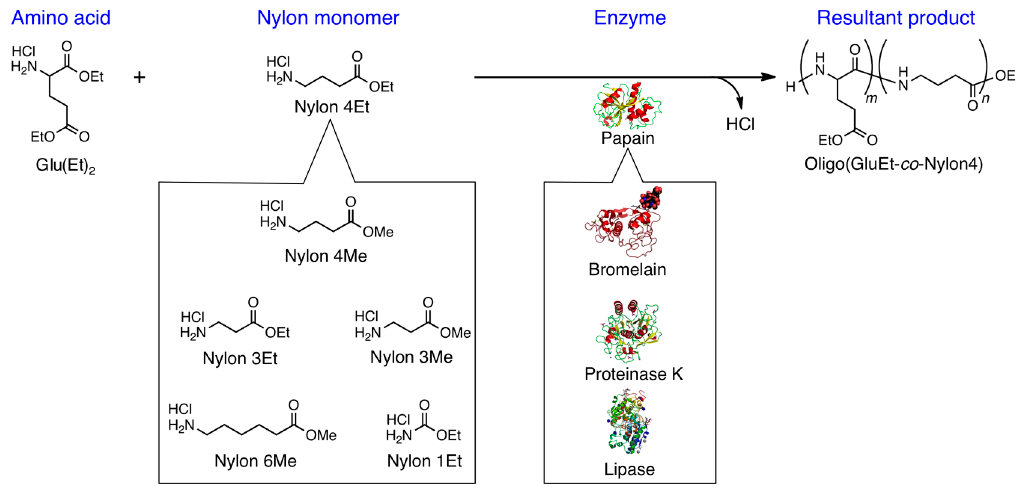
Figure 1. Schematic illustration of the copolymerization of amino acids and nylon monomers by chemoenzymatic synthesis. Glu(Et) 2 was used as a model amino acid, whereas six types of nylon monomer alkyl esters with various chain lengths were used as the nylon unit. Chemoenzymatic synthesis was performed using four enzymes, and their reaction efficiencies were investigated.